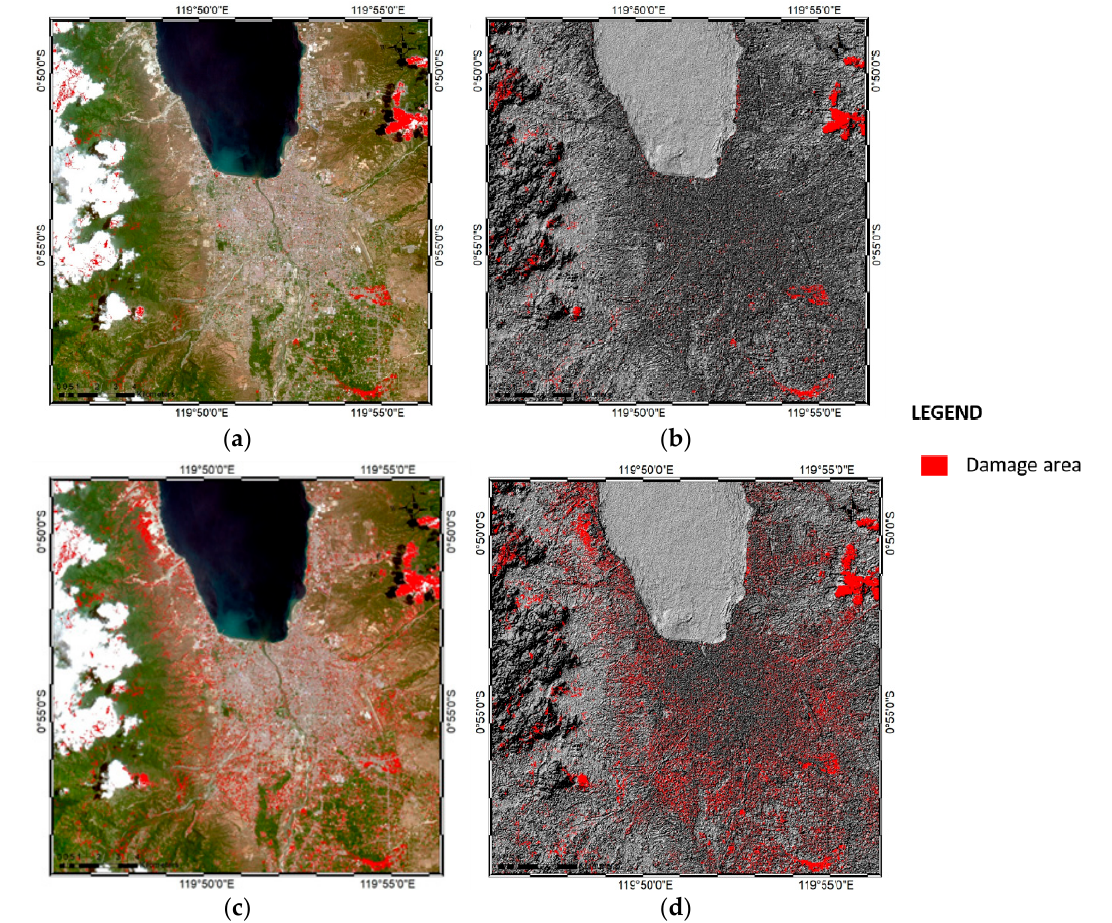
Figure 11. Post ‐ earthquake damage maps of Palu, Indonesia, generated using the decorrelation Figure 11. Post-earthquake damage maps of Palu, Indonesia, generated using the decorrelation method method from the ANN and SVM classification results of the Sentinel ‐ 2 images in ( a ) ANN true color from the ANN and SVM classification results of the Sentinel-2 images in ( a ) ANN true color view, view, ( b ) ANN hillshade view, ( c ) SVM true color view, and ( d ) SVM hillshade view. ( b ) ANN hillshade view, ( c ) SVM true color view, and ( d ) SVM hillshade